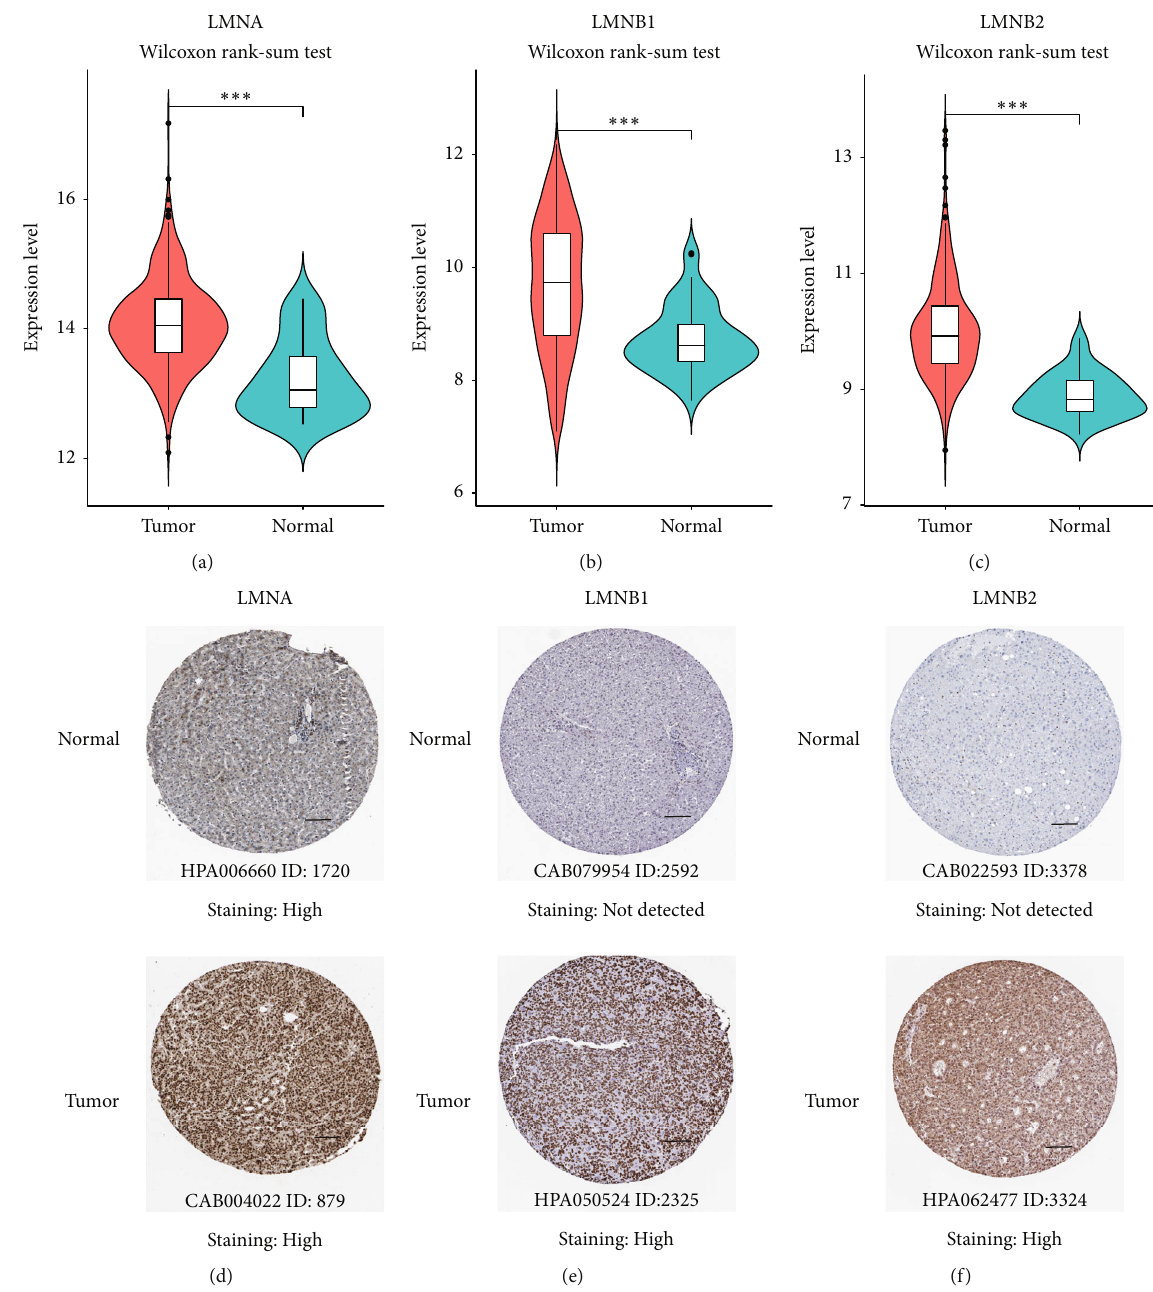
Figure 2: Expression levels of lamin family members in HCC. (a – c) The mRNA expression levels of LMNA, LMNB1, and LMNB2 in the TCGA database. Wilcoxon rank-sum test, ∗∗∗ P < 0 : 001 . (d – f) Representative immunohistochemistry images of LMNA, LMNB1, and LMNB2 in HCC and normal tissues from the HPA database; scale bar = 100 μ m